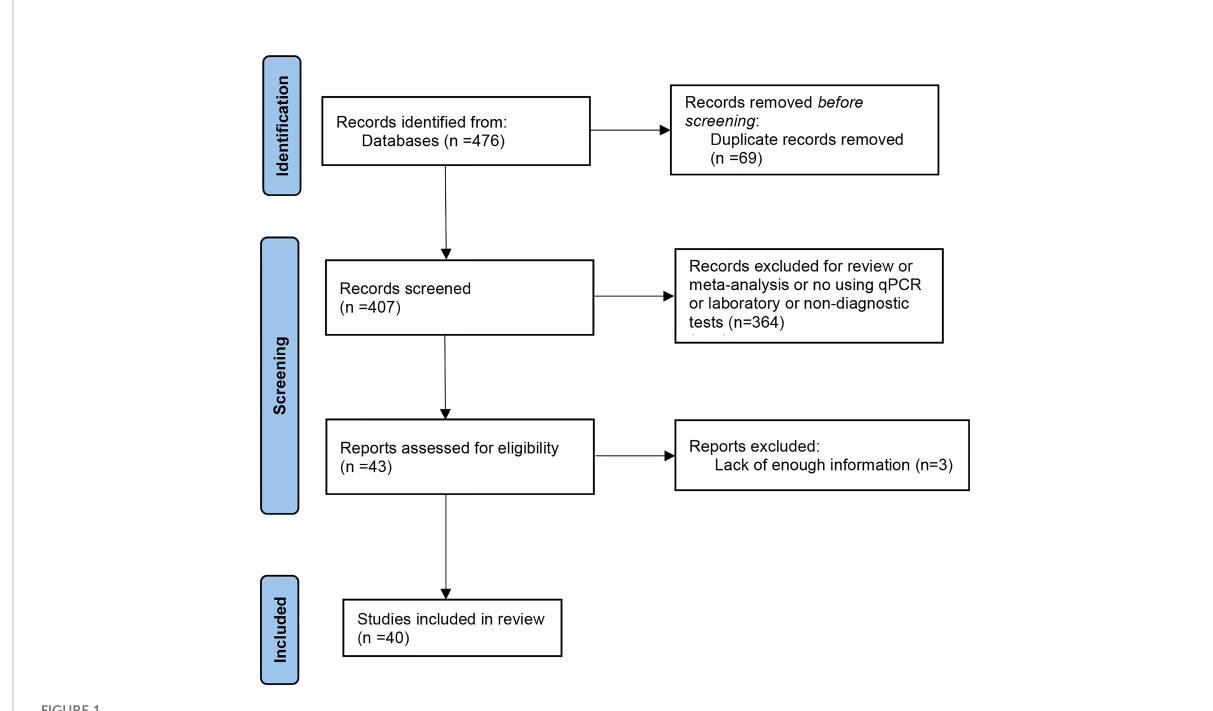
FIGURE 1 A fl ow diagram of the article selection process.